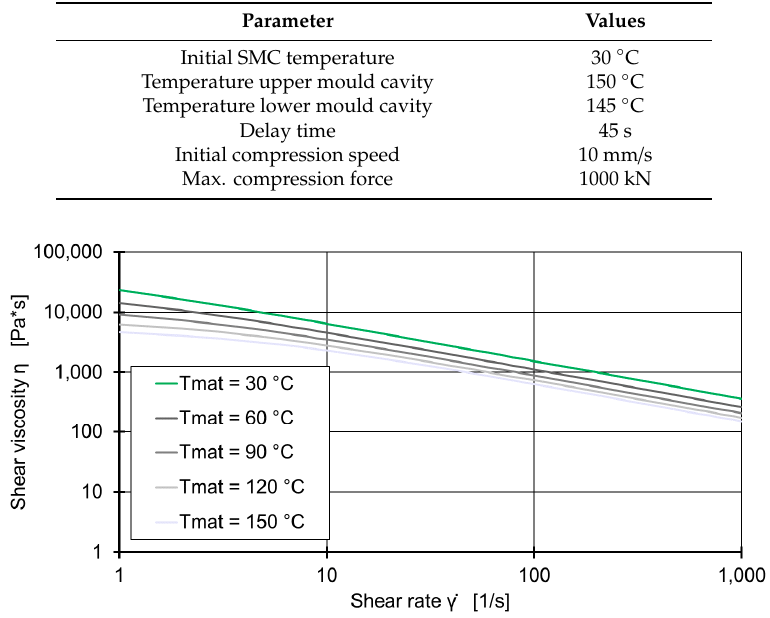
Figure 3. Shear rate and temperature-dependent viscosity [59].